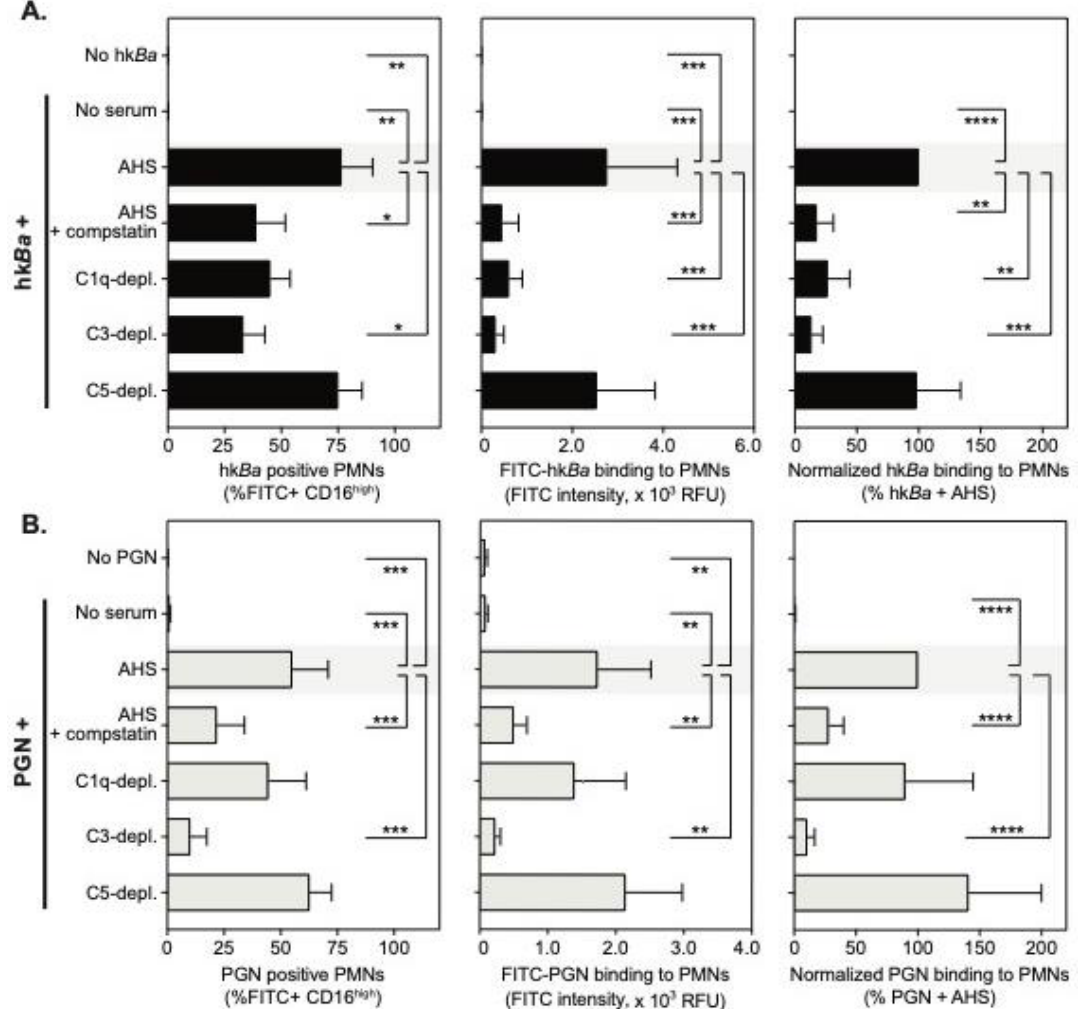
Figure 2. Flow cytometry quantitation of FITC-hk Ba ( A ) and / or the FITC-PGN ( B ) interaction with CD16 high neutrophils in the presence of compstatin, a C3 convertase inhibitor, or the immunodepletion of complement factors. Data, shown as mean ± SD of 4–8 independent donors, depict bacteria or PGN positive PMNs (left panels), total bacteria or PGN uptake (geometric mean of fluorescence intensity, middle panels) and normalized changes in fluorescence intensity compared to bacteria or PGN uptake in the presence of autologous serum (AHS) that is considered 100% (right panels). For each panel, statistically significant di ff erences compared to PAMPs + AHS (shaded) are depicted graphically (* p < 0.05; ** p < 0.01; *** p < 0.001; **** p < 0.0001) and were computed either by repeated measures one-way analysis of variance (ANOVA) with Holm–Sidak’s multiple comparisons test (left and middle panels), or by one sample t test compared to the normalized value (right panels).